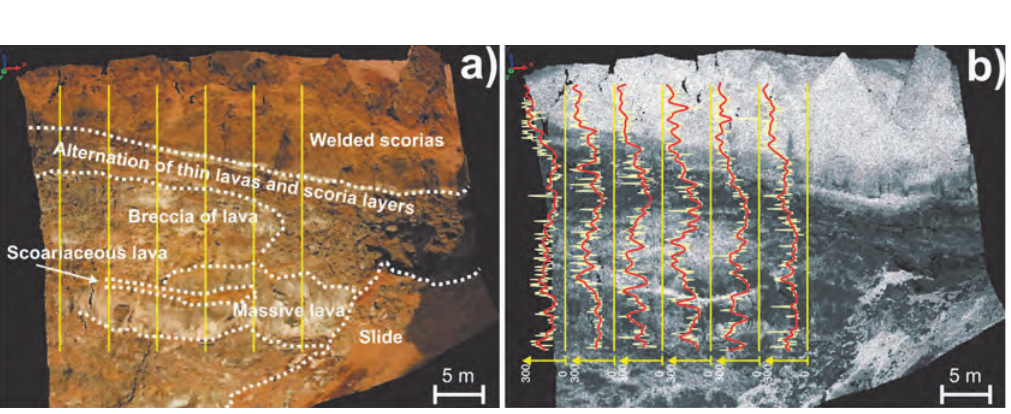
Fig. 11. Intensity of the six profiles selected in the B-zone (fig. 4). Data (in white) are smoothed (red line) us- ing a FFT filter to better display slow variations and examine the intensity trend along the sections. A common scale of 0-300 is